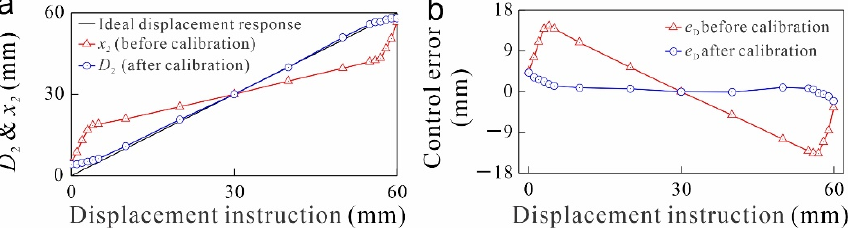
Figure 7. Experimental results of the LSEA displacement control. ( a ) Tracking of the output block displacement before and after inherent nonlinearity calibration of the potentiometer; ( b ) displacement control error of the output block before and after inherent nonlinearity calibration of the potentiometer.